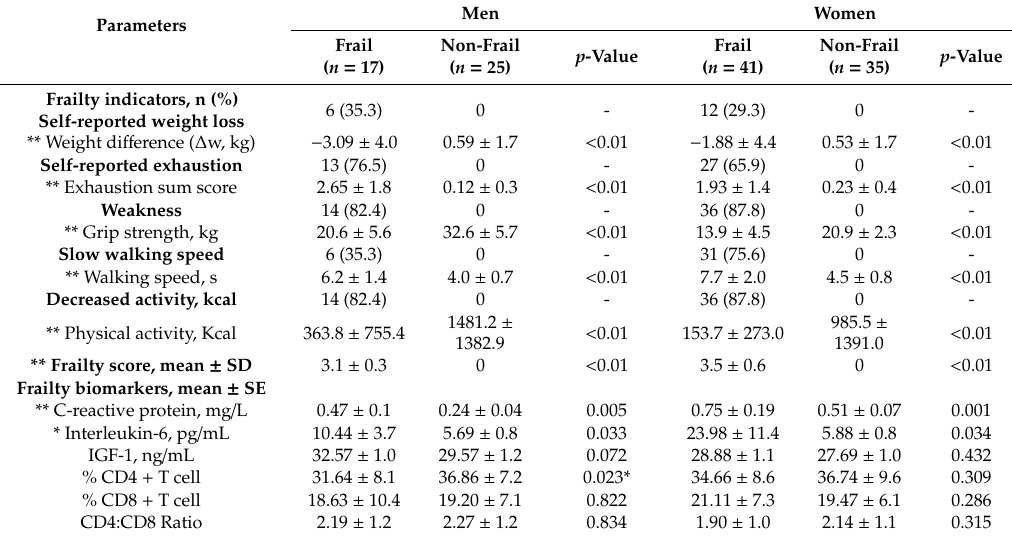
Table 5. Gender e ff ects on comparisons of frailty indicators and blood-based biomarkers between the frail and the non-frail phenotype [men ( n = 42) and women ( n =